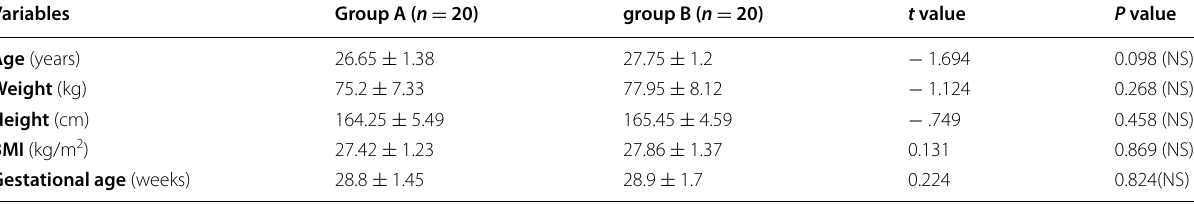
Table 1 General characteristics of the two studied groups (A and B)